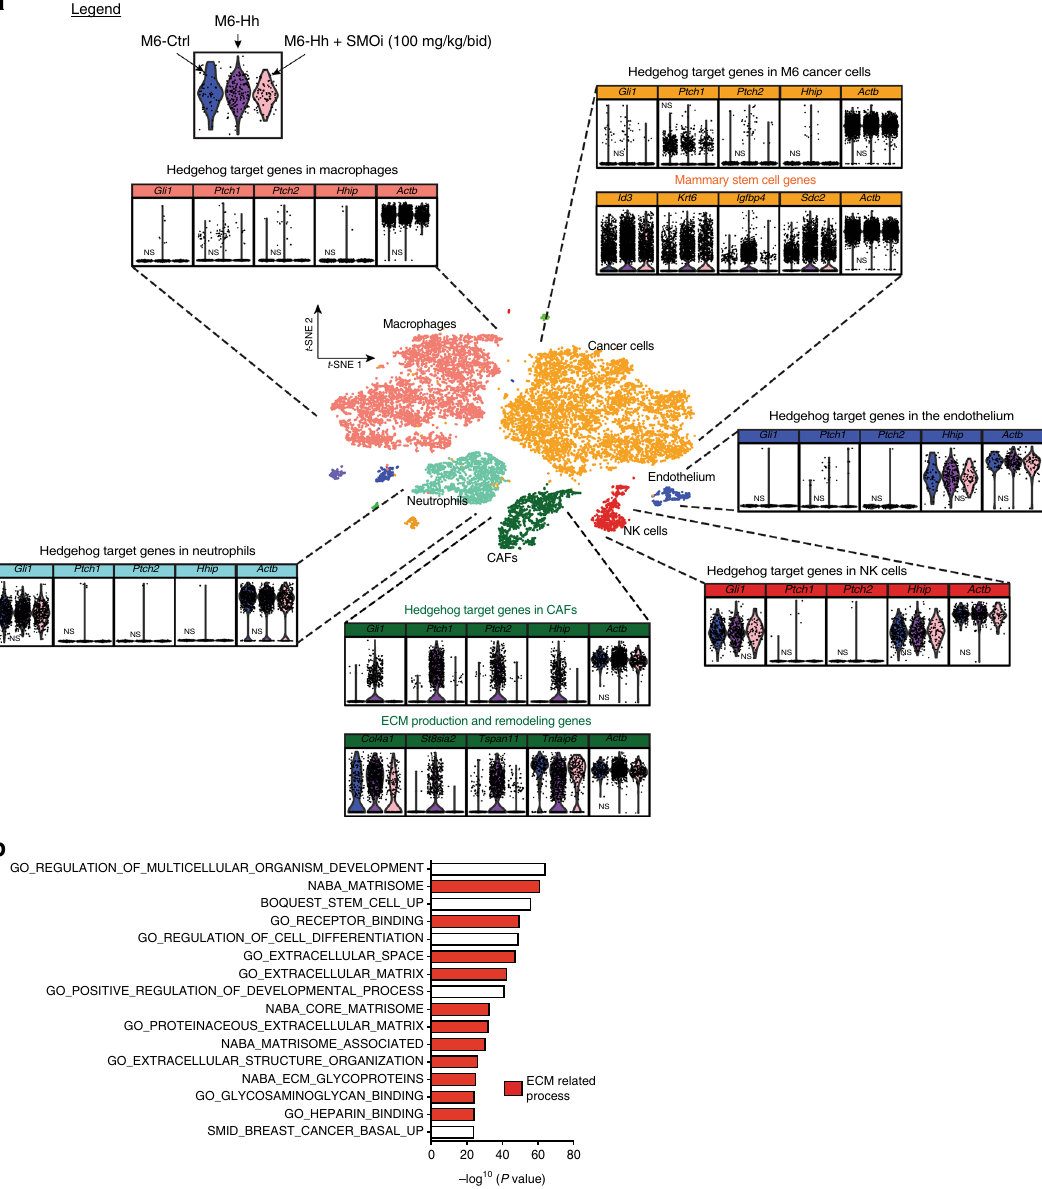
Fig. 3 Paracrine Hedgehog signaling at cellular resolution. a Freshly isolated M6-Ctrl (blue), M6-Hh (magenta) and M6-Hh tumors + SMOi (100 mg/kg/ bid; pink violin plot) were captured using 10x Chromium technology and the Cell Ranger Single Cell Software Suite 2.0 was used to perform demultiplexing, barcode processing, and single-cell 3 ′ gene counting. t -SNE plot shows the subcellular clusters present in the breast TME of M6 tumors. Unless stated, P values are highly signi fi cant (Supplementary Data 2). b Single-cell RNA-Seq analysis reveals signi fi cant enrichment of GSEA groups related to ECM organization and production speci fi cally in the CAF population of M6-Hh tumors (ECM-related processes highlighted in red; FDR q value <